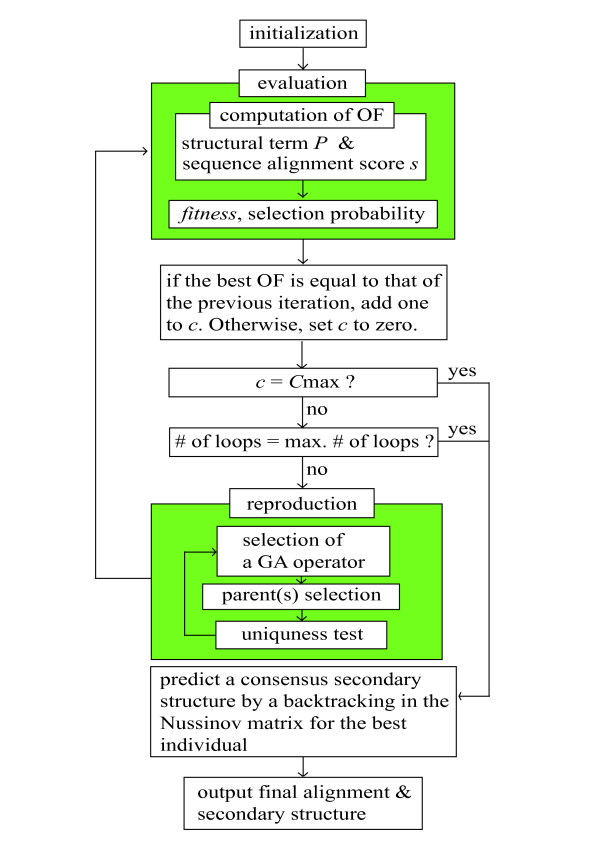
Schematic flowchart of Cofolga2 algorithm. Cofolga2 algorithm is composed of three GA steps (initialization, evaluation, and reproduction) and a postprocessing step. In initialization, a population of individuals is randomly generated by weighted stochastic backtracking. In evaluation step, the objective function of each individual is evaluated and then fitness and selection probability are assigned to each individual. In reproduction, half of the population is replaced by new individuals to update the population. The iteration between evaluation and reproduction stops when one of the following conditions is satisfied: the best OF is not updated continuous Cmax times, or the number of iteration reaches a pre-defined maximum iteration number. The Cmax and the maximum iteration number are parameters given by user. A consensus secondary structure prediction for the optimal alignment is performed as a postprocessing, where the Nussinov matrix constructed by averaged base pairing probabilities is backtracked.